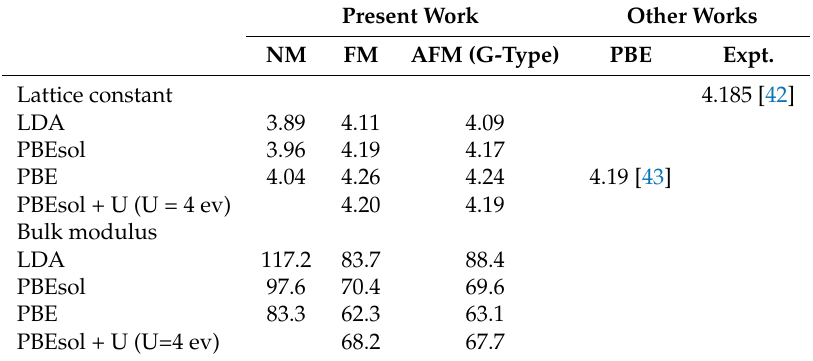
Table A1. Lattice constant (Å) and bulk modulus (GPa) of cubic KMnF 3 for different methods used in this